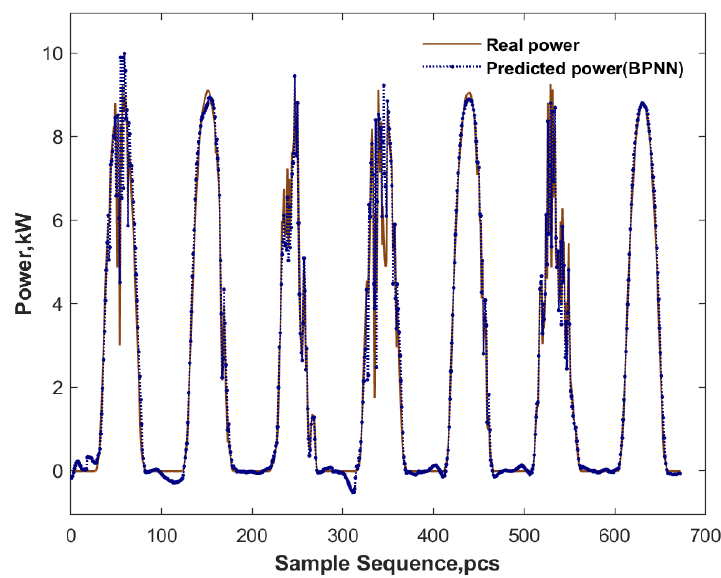
Figure 4. BPNN model prediction